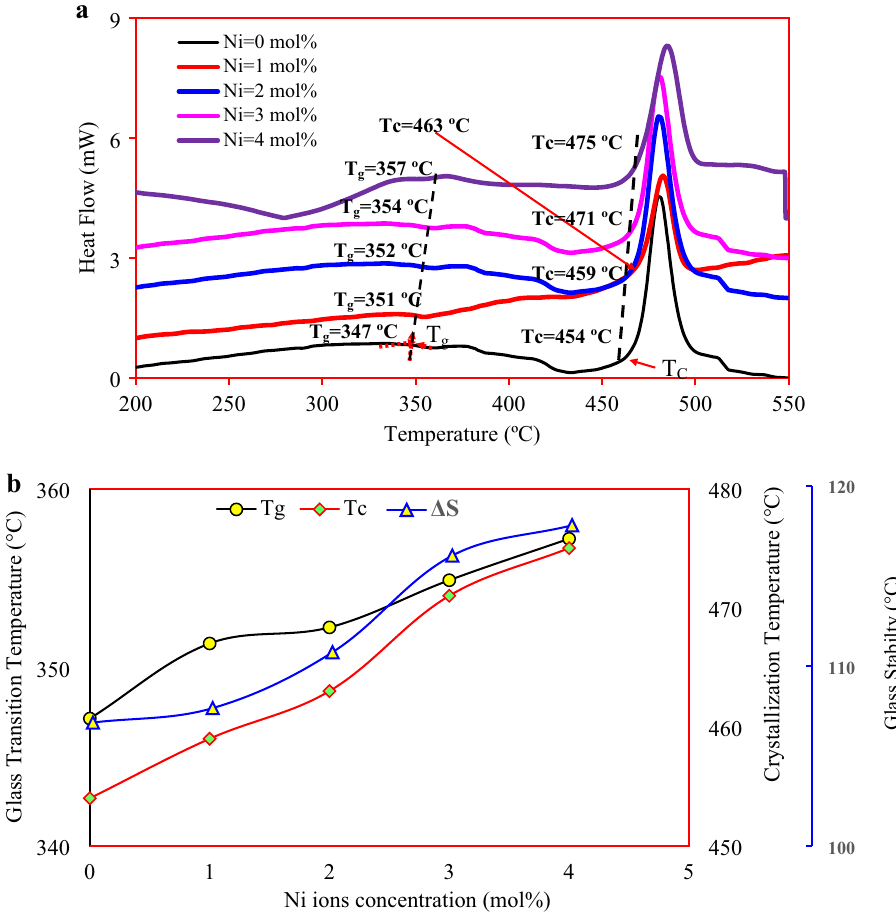
Figure 5. ( a ) DSC thermograms ( b ) Variation of glass transition temperature T g , crystallization temperature T C , and thermal stability (cid:31) S